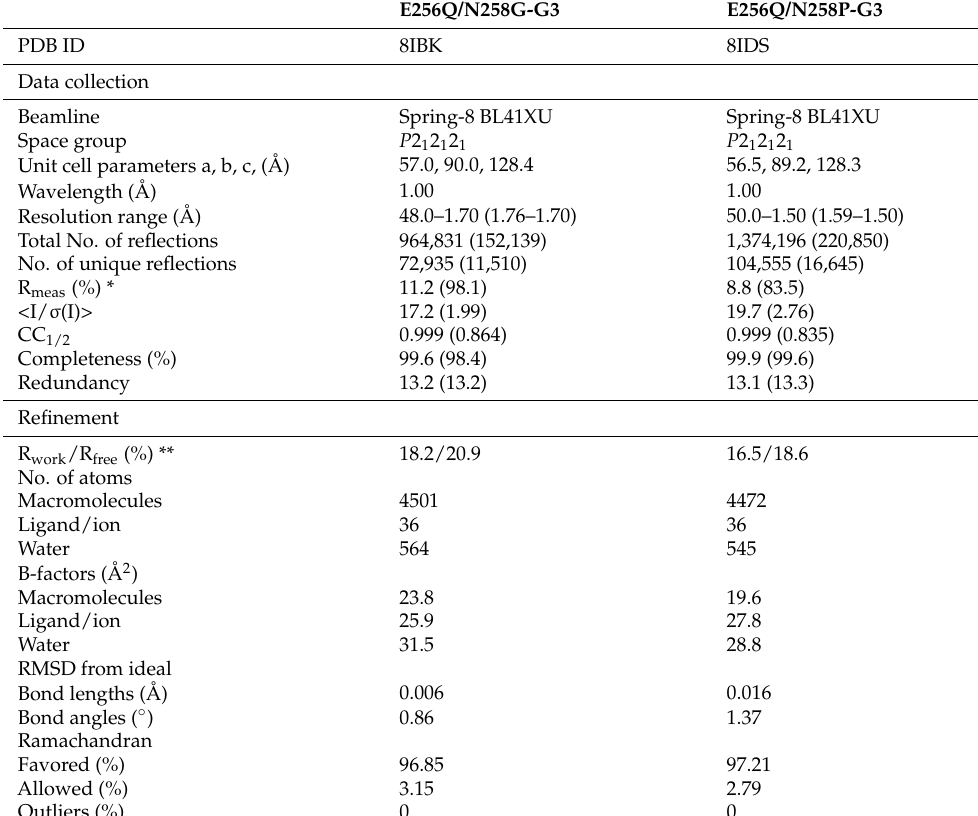
Table 5. Summary of data collection and refinement statistics.